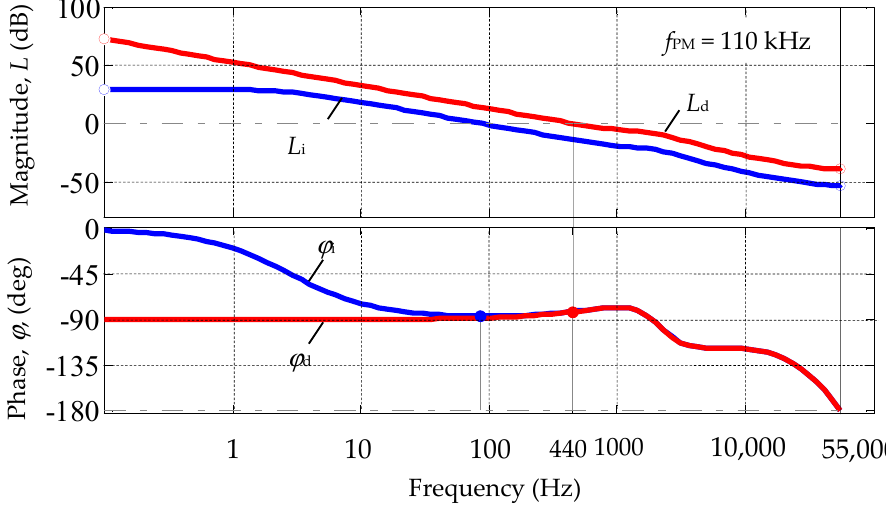
Figure 11. Initial L i , ϕ i and desired L d , ϕ d frequency response of the system.